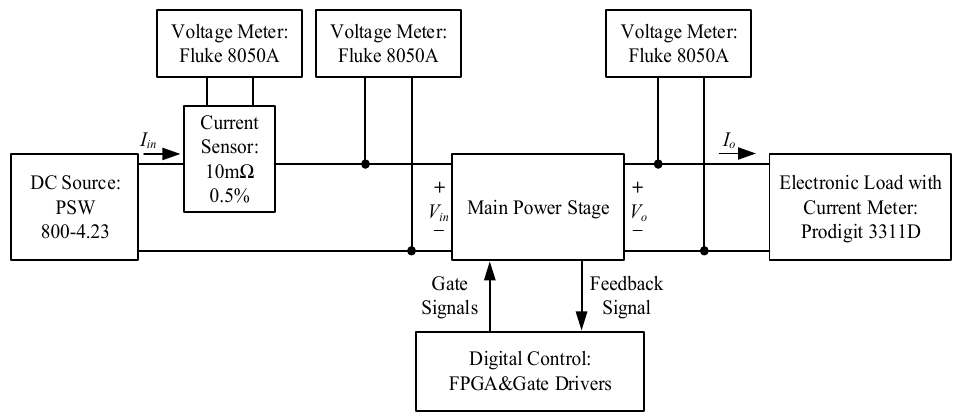
Figure 14. Test bench for measuring efficiency.